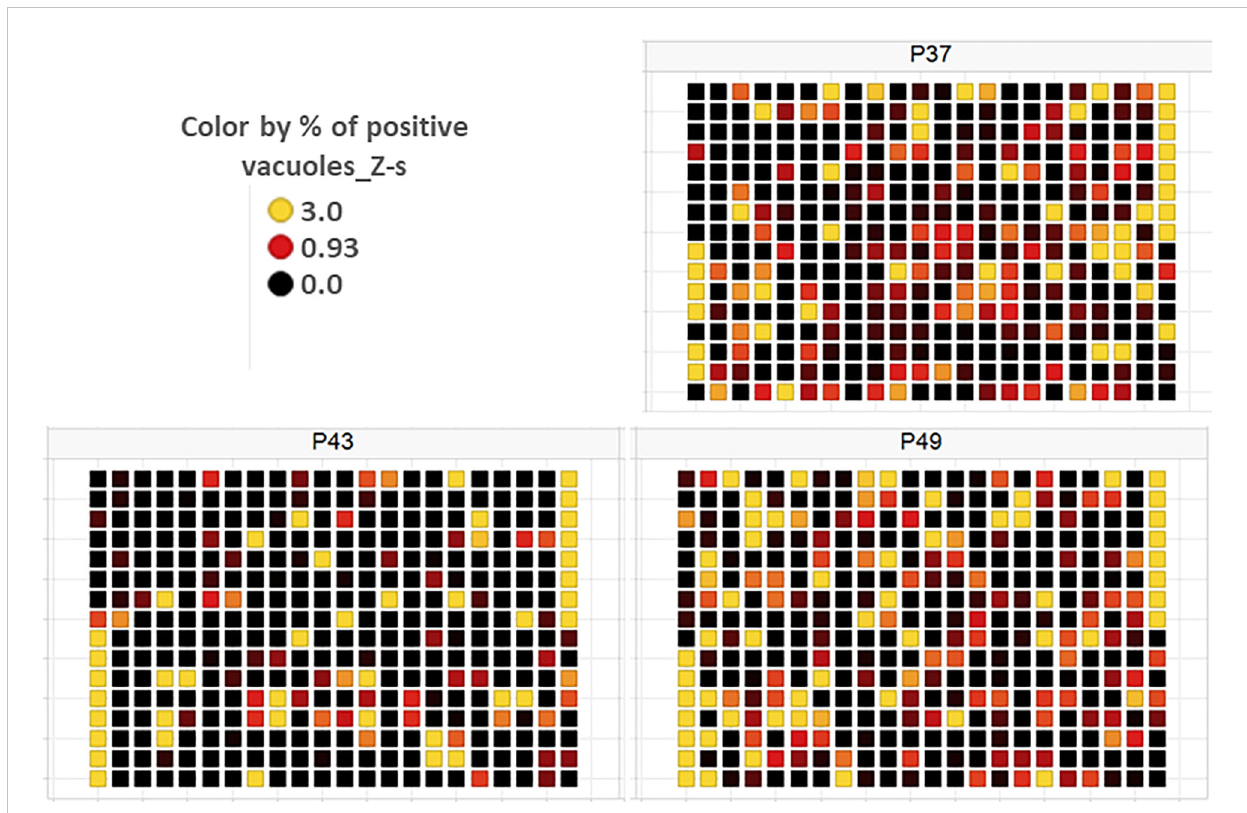
FIGURE 5 Plate heat map for each of the three screening plates (P37, P43 and P49) for each well, where each square corresponds to a well. DMSO was dispensed in the 1 st eight rows of the 1 st column and the last eight rows of the 21 st column, while the two compounds — SB 239063 (Cpd2) and SB 208 (Cpd3) — were placed in the last eight rows of the 1 st and the fi rst eight rows of the 21 st column, respectively. For each well, the Z-score determined on the percentage of vacuoles displaying disruption is given, with Z-score > 3 indicating a compound impacting vacuole disruption.